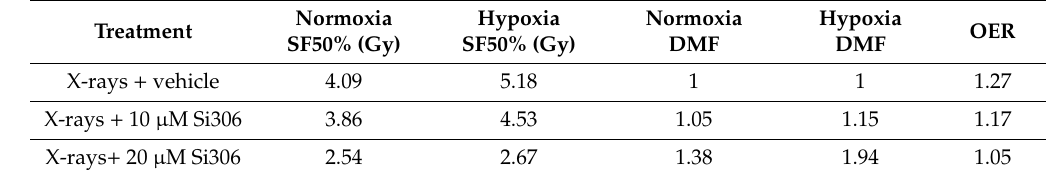
Table 1. Dose modifying factor (DMF) and oxygen enhancement ratio (OER) values calculated as isoe ff ective dose at surviving fraction of 0.5.